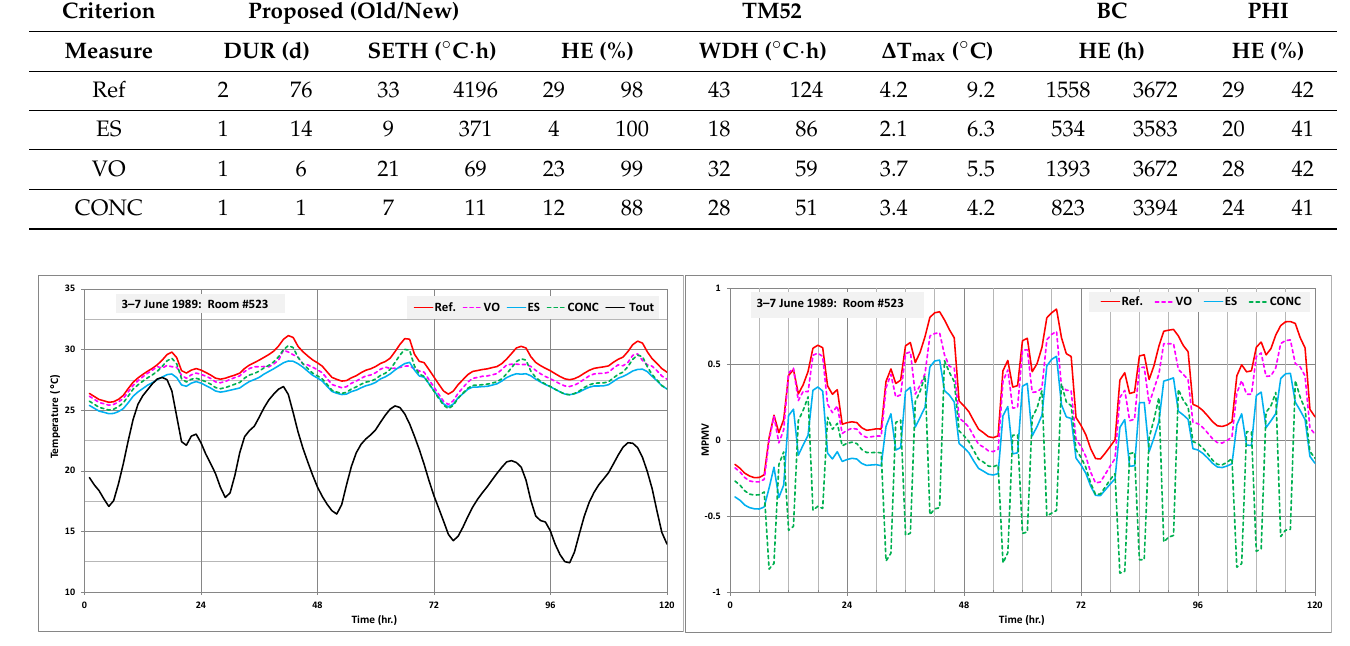
Table 9. Inter-comparison of overheating criteria for bedroom #523 of old and new LTCHs.